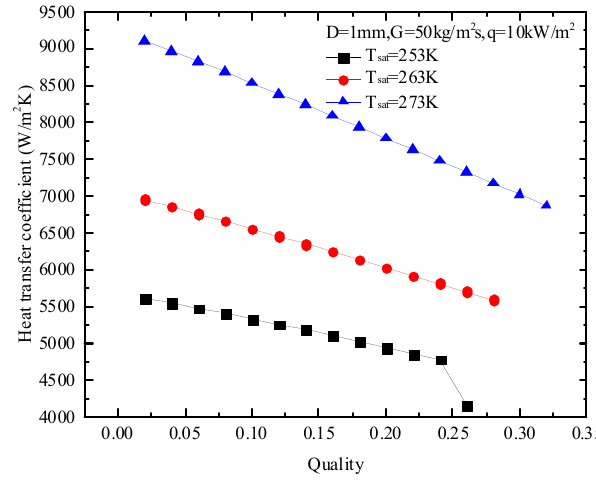
Energies 2023 , 16 , x FOR PEER REVIEW Figure 14. Effect of T sat on heat transfer coefficient of R744. Figure 14. Effect of T sat on heat transfer coefficient of R744.